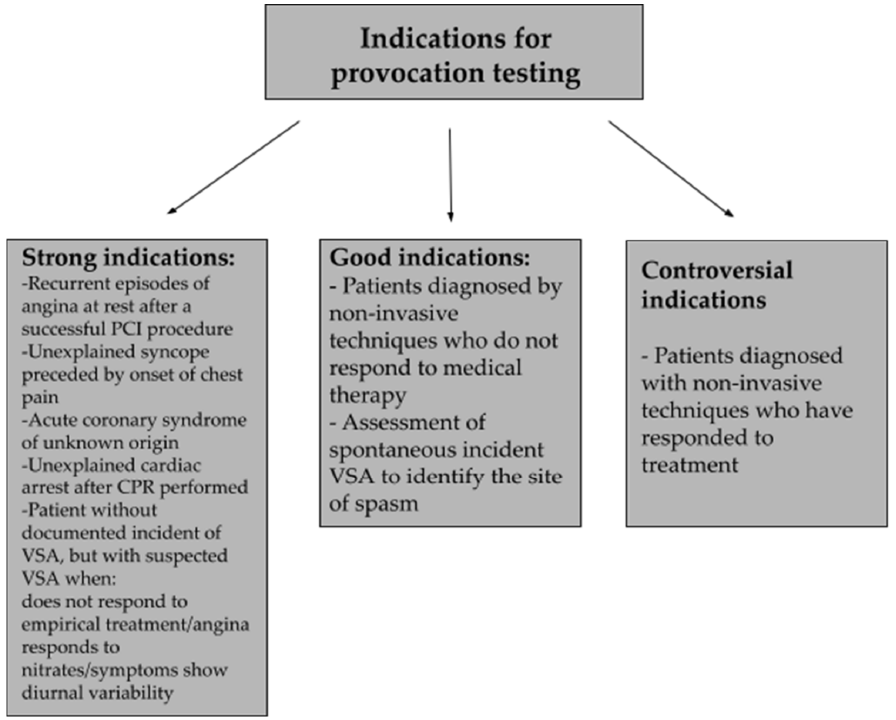
Figure 2. Some of the indications for the provocative test including their division [81].